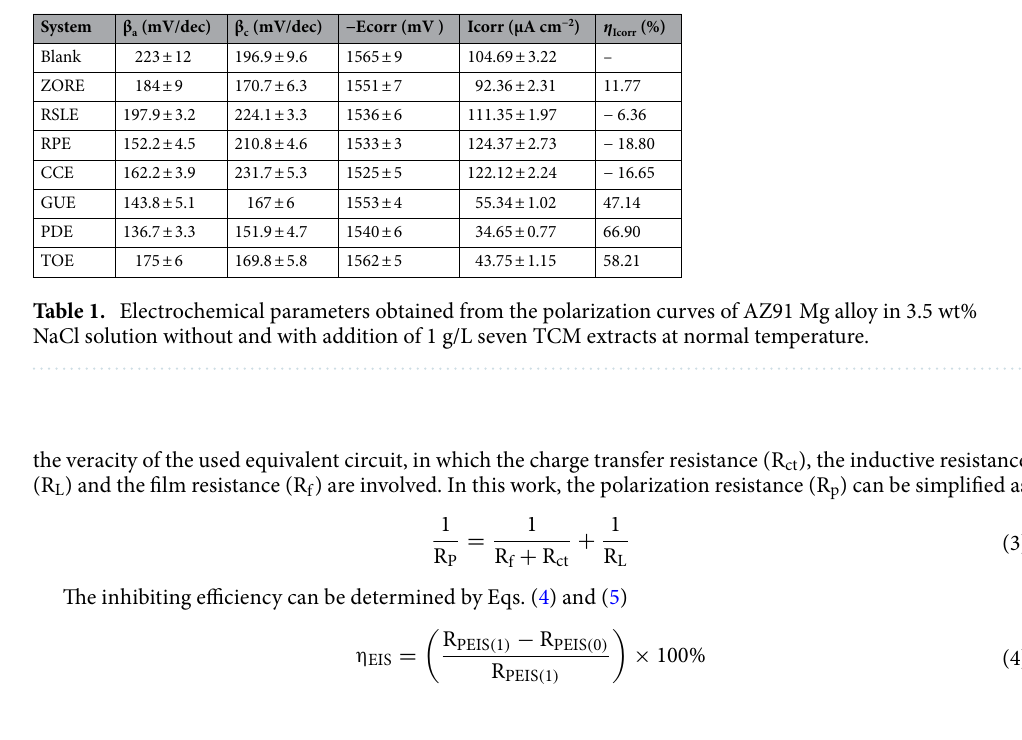
Figure 1. Electrochemical tests of AZ91 Mg alloy in 3.5 wt% NaCl solution without and with seven 1 g/L TCM extracts. ( a ) Potentiodynamic polarization curves; ( b ) Electrochemical impedance spectra; comparisons between original data and fitted results of ( c ) EIS curves and ( d ) bode diagrams of the AZ91 alloy and a typical AZ91alloy upon the addition of PDE.